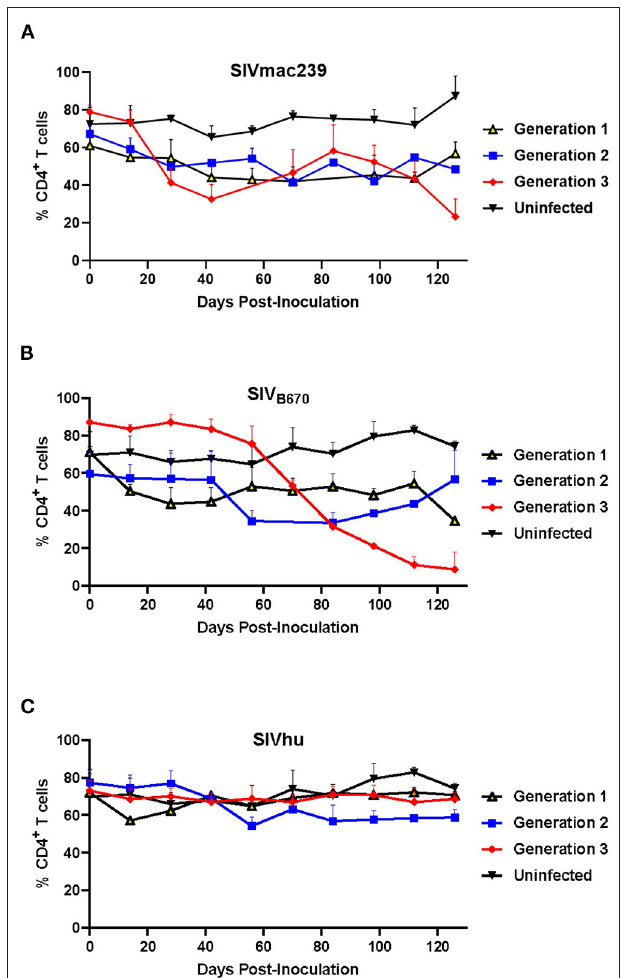
FIGURE 2 | CD4 + T cells levels during three generations of serial passage of SIVmac239, SIV B670 , and SIVhu in humanized mice. (A) SIVmac239, (B) SIV B670 , and (C) SIVhu CD4 + T cell levels over three generations. CD4 + T cell levels were monitored bimonthly using flow cytometry. The percent of CD4 + T cells is presented relative to that of CD45 + /CD3 + cell populations. Statistically significant CD4 + T cell depletion was seen in the third generation